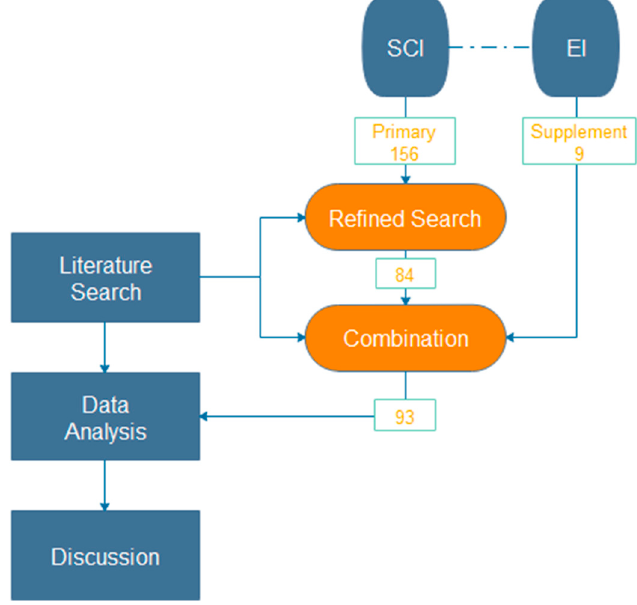
Figure 1. The process of literature database construction.